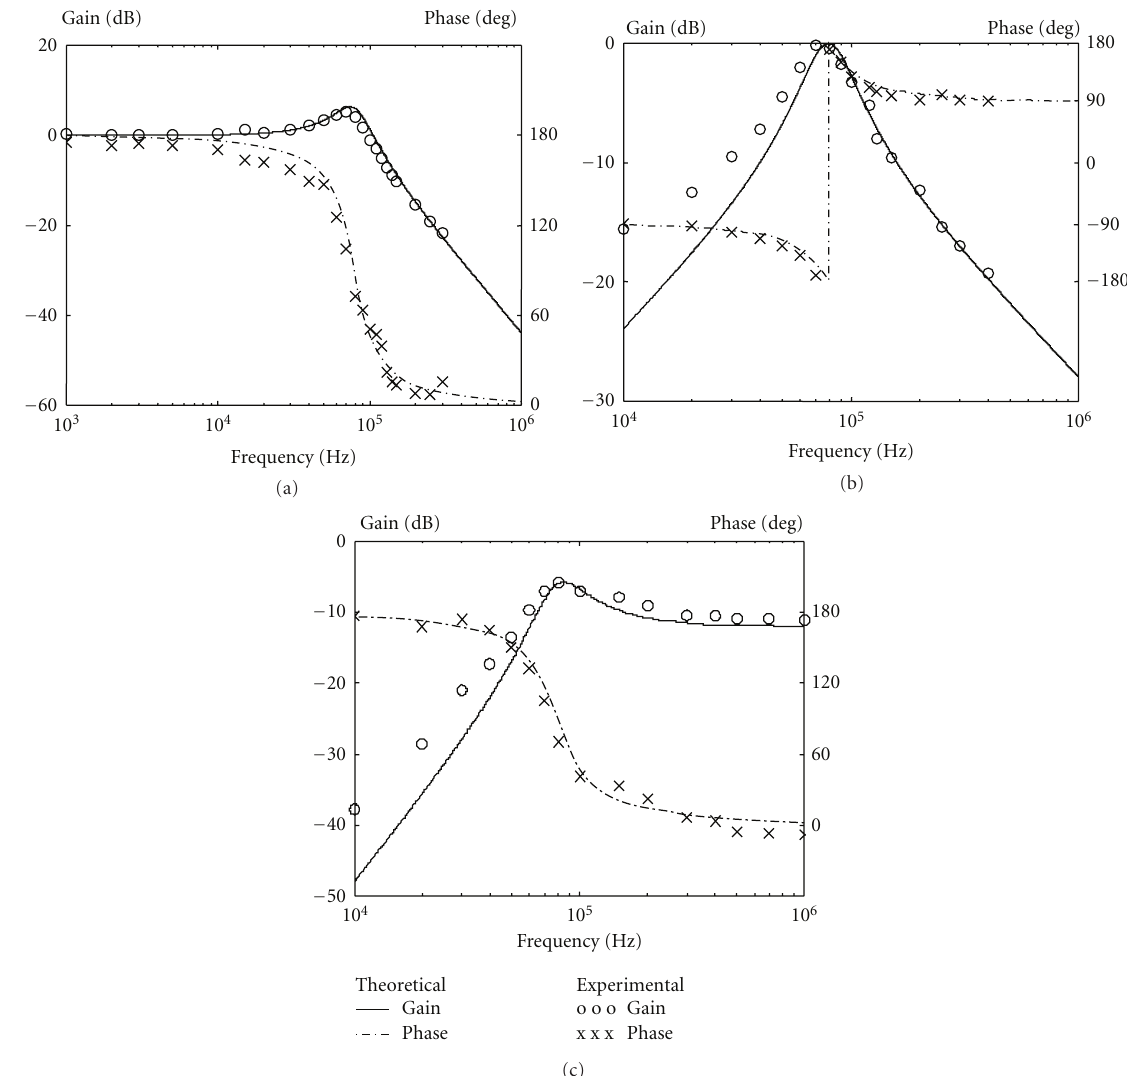
Figure 4: Experimental frequency responses of Figure 1 design with C 1 = C 2 = 100pF and R 1 = R 2 = R 3 = R 4 = R 5 = 10k Ω : (a) lowpass filter ( V lp ), (b) bandpass filter ( V bp ), and (c) highpass filter ( V hp